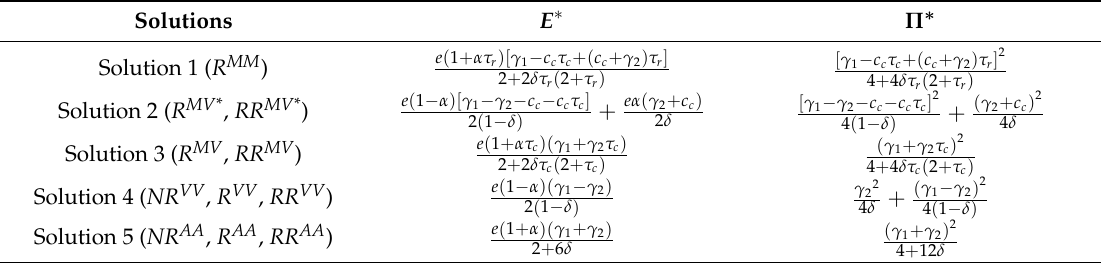
Table 5. Optimal profits and carbon emissions in absence of cap-and-trade